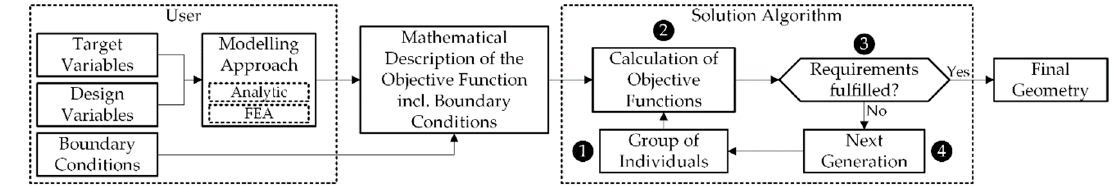
Figure 3. Stochastic method with physical model. Distinct properties are numbered and detailed.